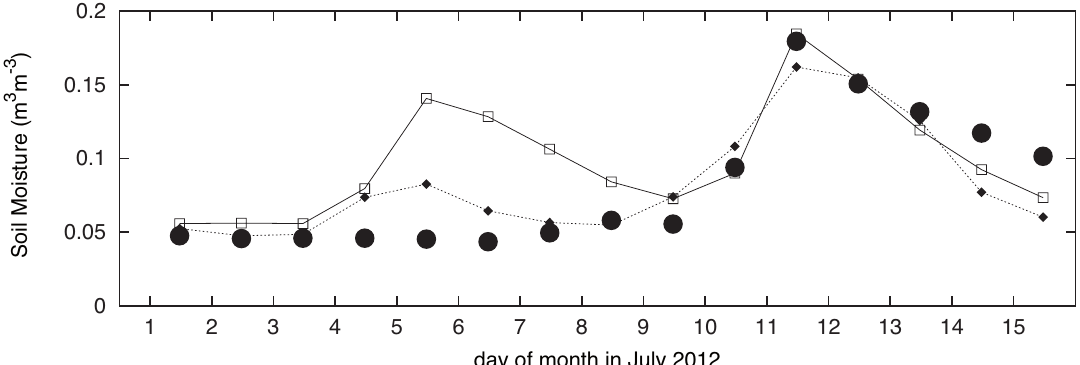
Figure 11. Mean daily soil moisture observations (filled dots), averaged over the Crossroads (33.54N, 103.24W) and Lehman (33.63N, 102.75W) stations of the SCAN network in US. Overlapped are the daily averaged analyses of CTRL (solid line and empty squares) and EXPT experiments (dotted line and